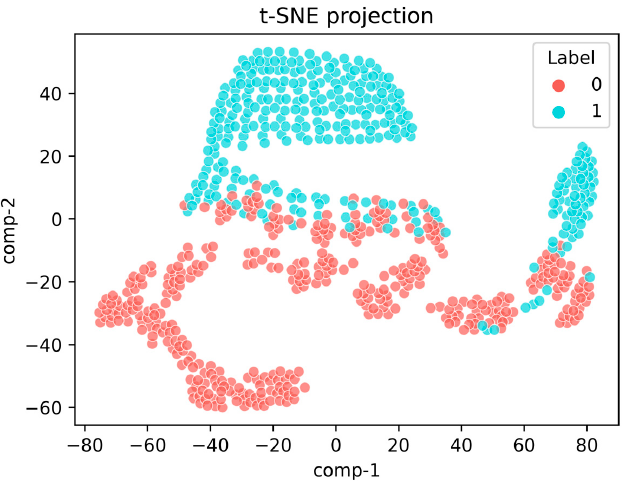
Figure 9. t-SNE visualization of the obtained features.